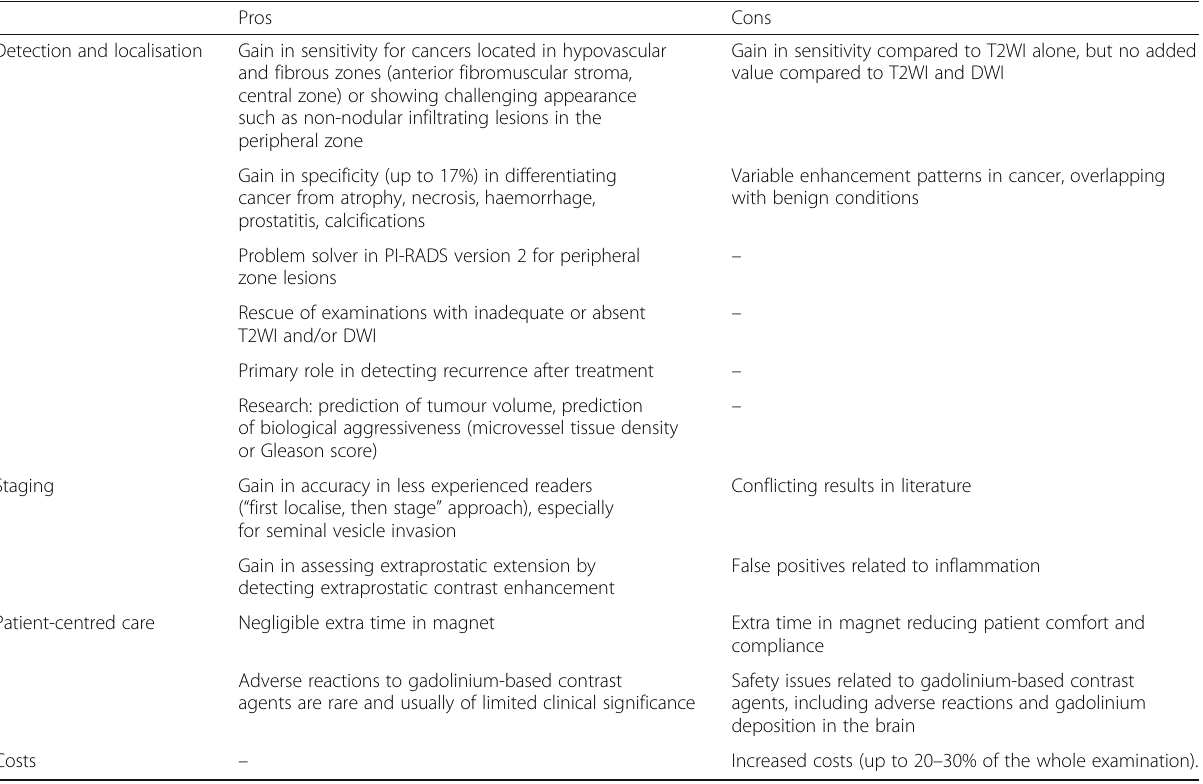
Table 3 Pros and cons of performing DCE imaging in prostate mpMRI compared to the combination of T2WI and DWI Pros Cons Detection and